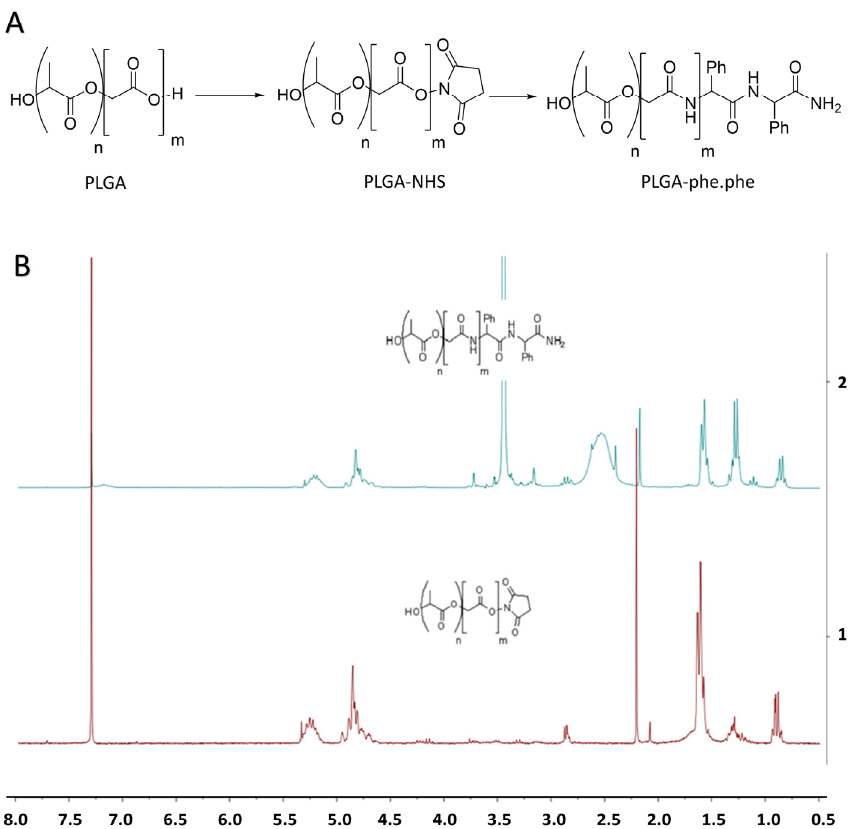
Figure 1. ( A ) Reaction scheme for the activation of carboxylic acid groups in PLGA and its functionalization. ( B ) H1 NMR patterns of PLGA-NHS (upper) and PLGA-phe-phe (lower). NHS: N-hidroxysuccinimide; phe-phe: phenylalanine dipeptide.